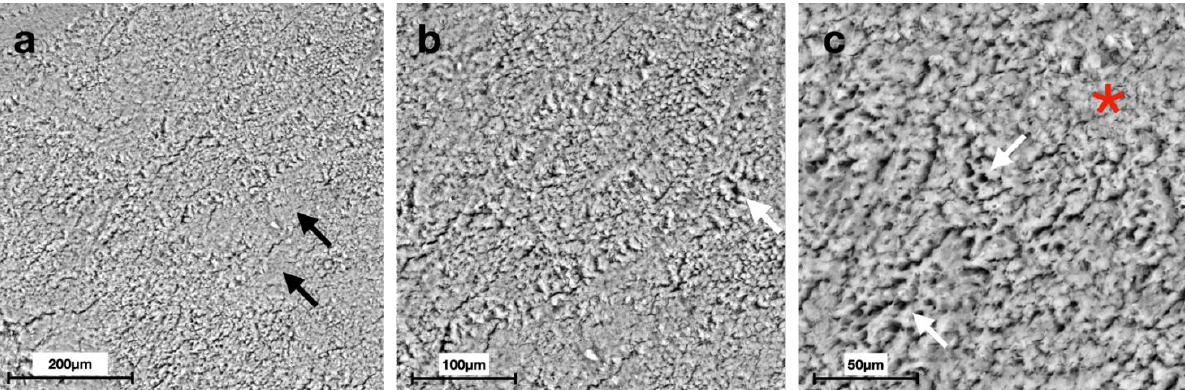
Figure 4. Scanning electron micrographs of G1 (Mousse Group): ( a ) intact morphology of the enamel surface (black arrows) at 200× magnification; ( b , c ) the partial recovery of the prism crystals (red asterisks) with the presence of a slight interprismatic dissolution (white arrows) at 500× and 1000× magnification, respectively.